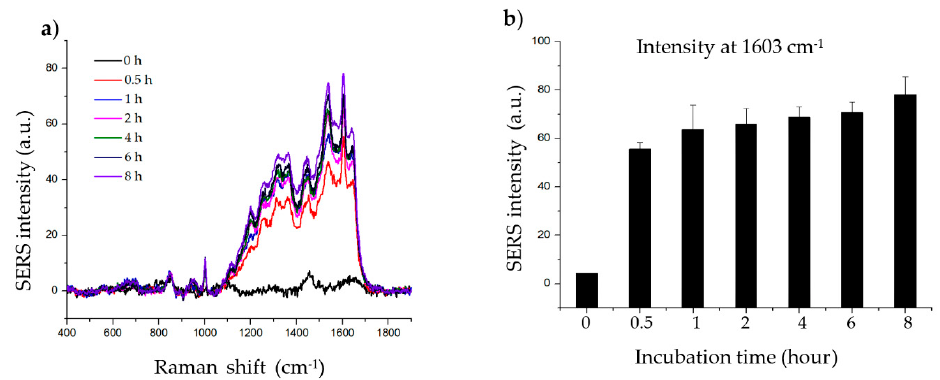
Figure 3. Effect of incubation time on histamine detection. ( a ) Raman signal of histamine incubated